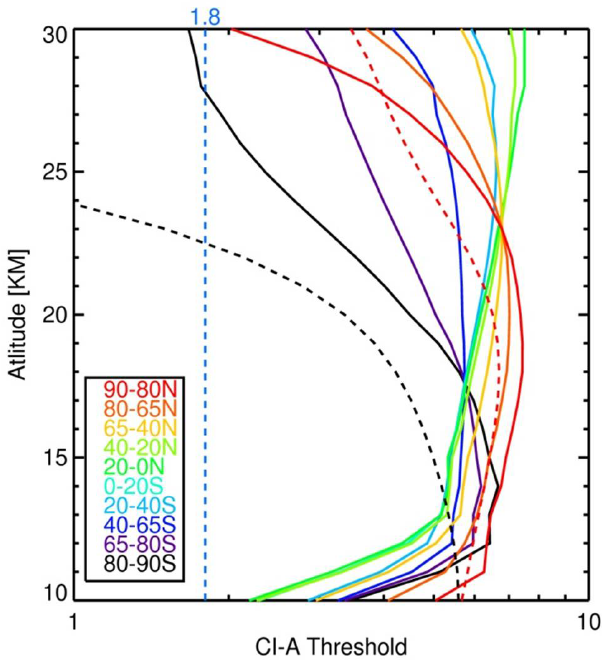
Fig. 2. CI-A threshold profiles for MIPAS from 10km to 30km. Threshold profiles are represented on a latitude grid of 90 ◦ –80 ◦ , 80 ◦ –65 ◦ , 65 ◦ –40 ◦ ,40 ◦ –20 ◦ and 20 ◦ to 0 ◦ for Northern and South- ern Hemispheres. Profiles are colour-coded for each latitude band (see legend); dotted lines show Arctic (red) and Antarctic (black) thresholds calculated for polar vortex conditions (with enhanced ClO, reduced stratospheric temperature, HNO 3 and O 3 ) . The blue vertical dotted line indicates a fixed threshold of